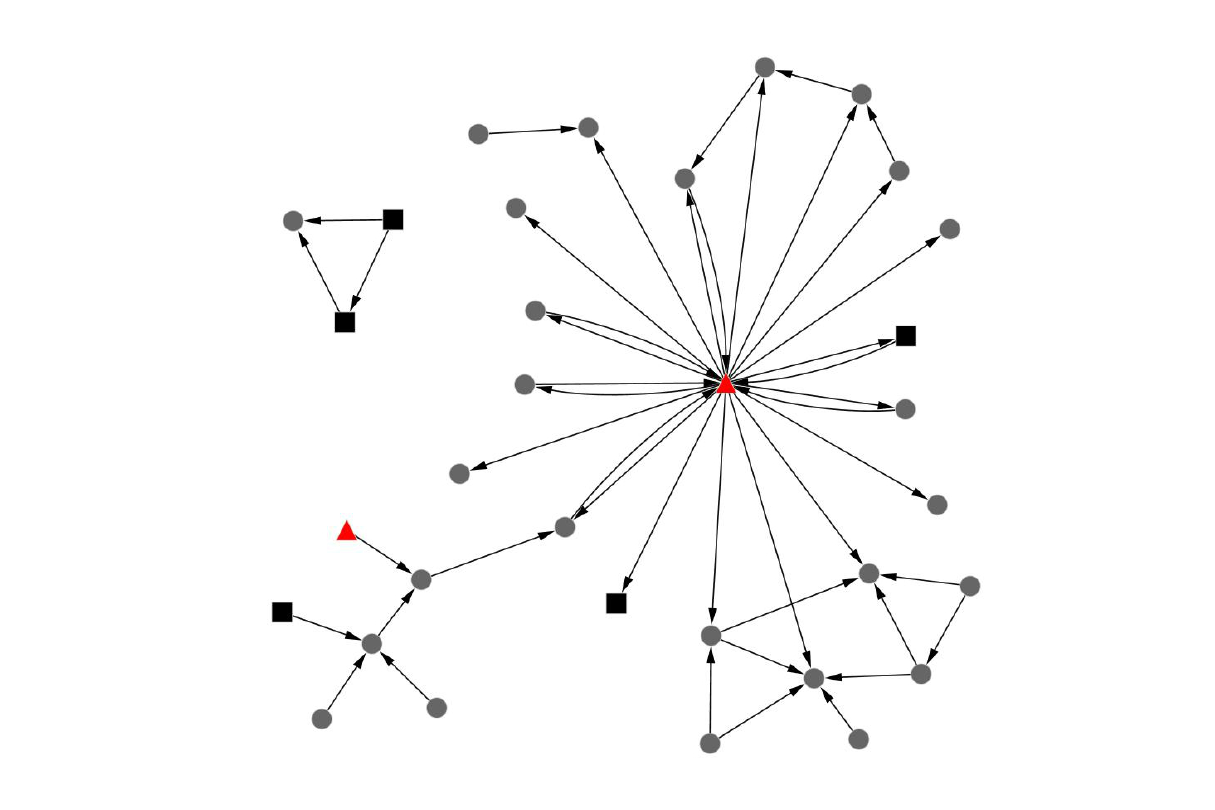
Figure 2. Networks for the Men’s Health forum. Grey circles are male, black squares are female, the Healthy.me GP and/or counselor is represented in the red